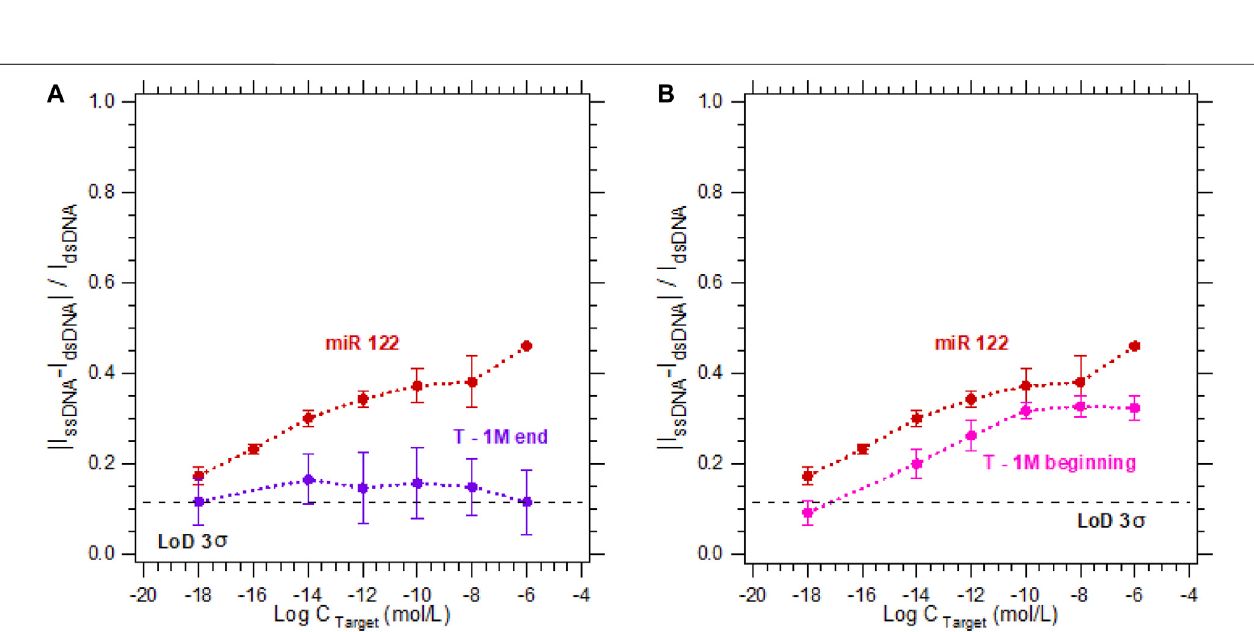
FIGURE 5 | Calibration curves in 3 mM [Fe (III) (CN) 6 ] 3 − /[Fe (II) (CN) 6 ] 4 − and 0.5 M NaCl with 5 µM MB for the detection of DNA target at concentrations varying from 10 − 18 M to 10 − 6 M. For a DNA target complementary to the DNA probe sequence (red dots — called miR 122) compared to the calibration curves of a sequence with a one-base mismatch located (A) at the end (purple dots), or (B) at the beginning (pink dots) of the strand.